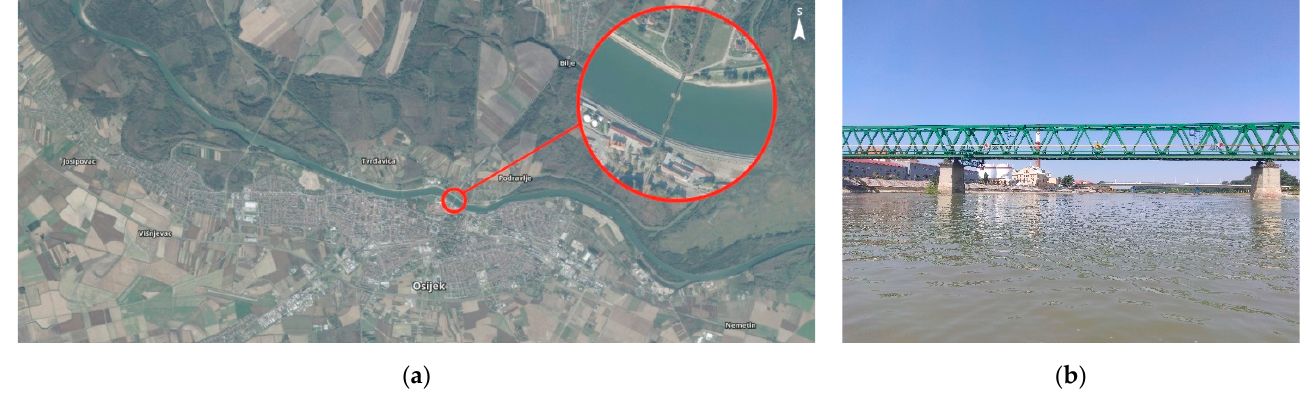
Figure 1. Orthophoto map of the case study area ( a ), photo of the bridge ( b ). Table 1. Summary of the measured hydraulic and hydrologic parameters from field surveys.